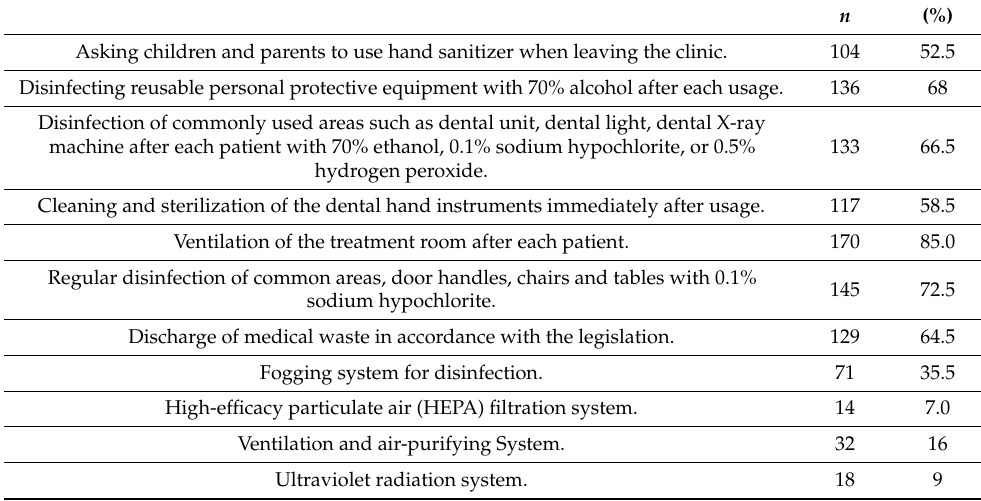
Table 12. Infection control practices used by the participants/institutions after treatment.